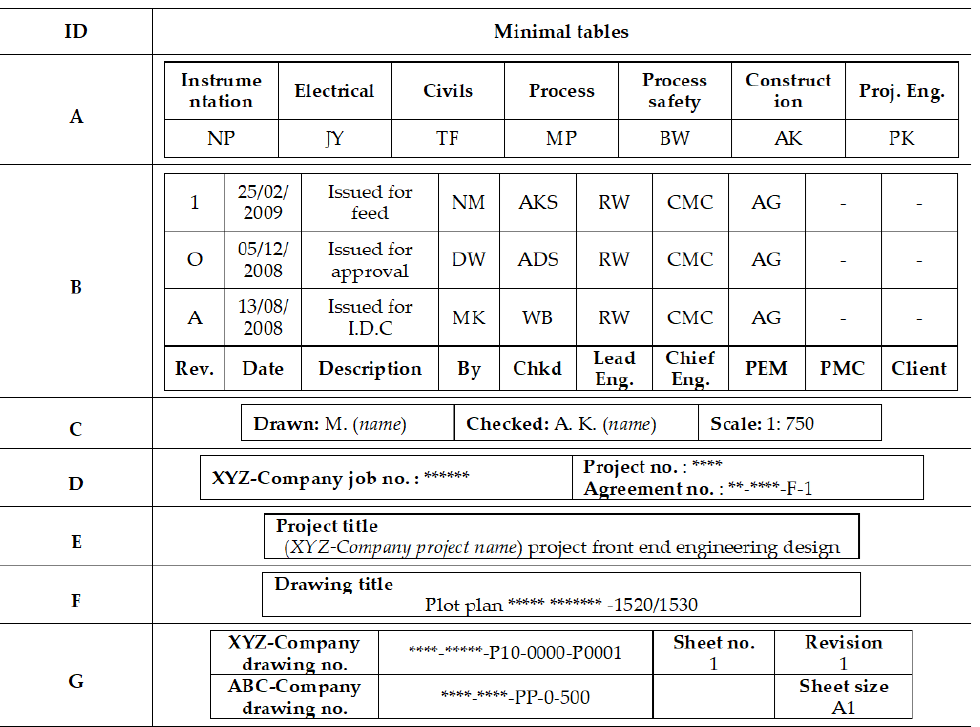
Figure 5. Minimal tables identified from the table in Figure 2.